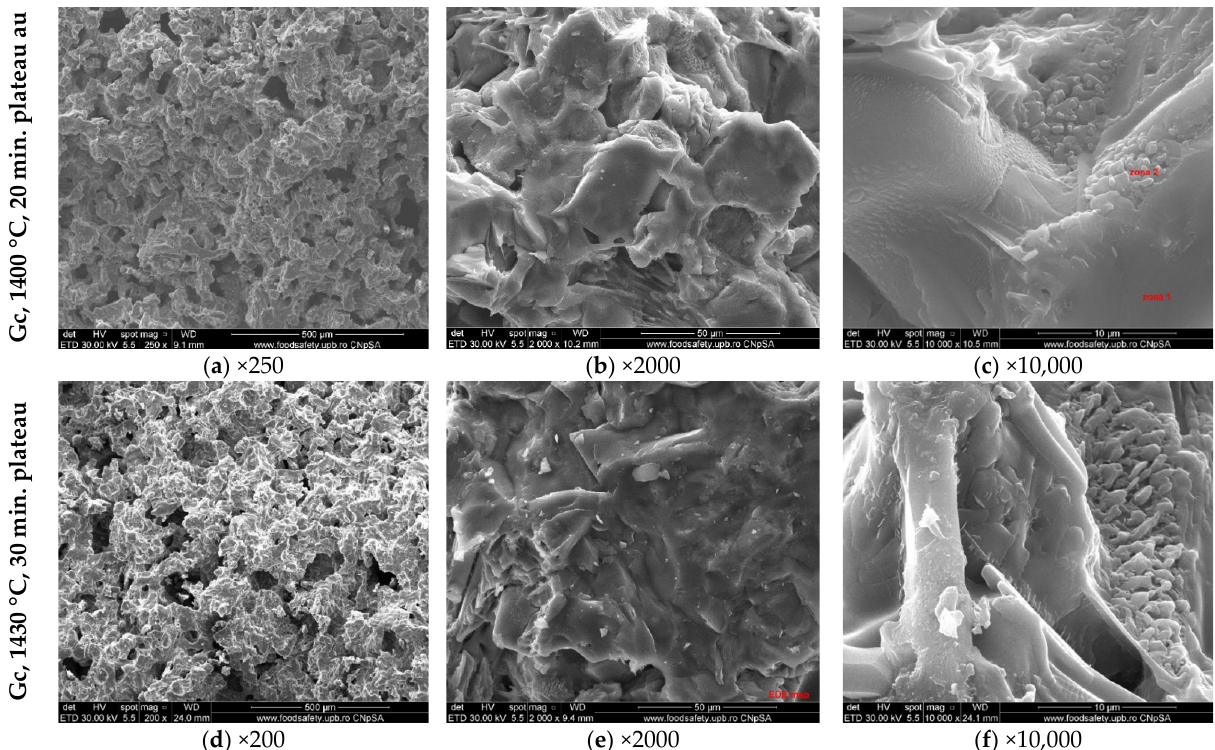
Figure 7. SEM image ( a ) and elemental mapping ( b – f ) of Rc clinker. The SEM images of the clinkers obtained by calcination at different temperatures and plateaus of the raw mix with clay and WG are presented in Figure 8.